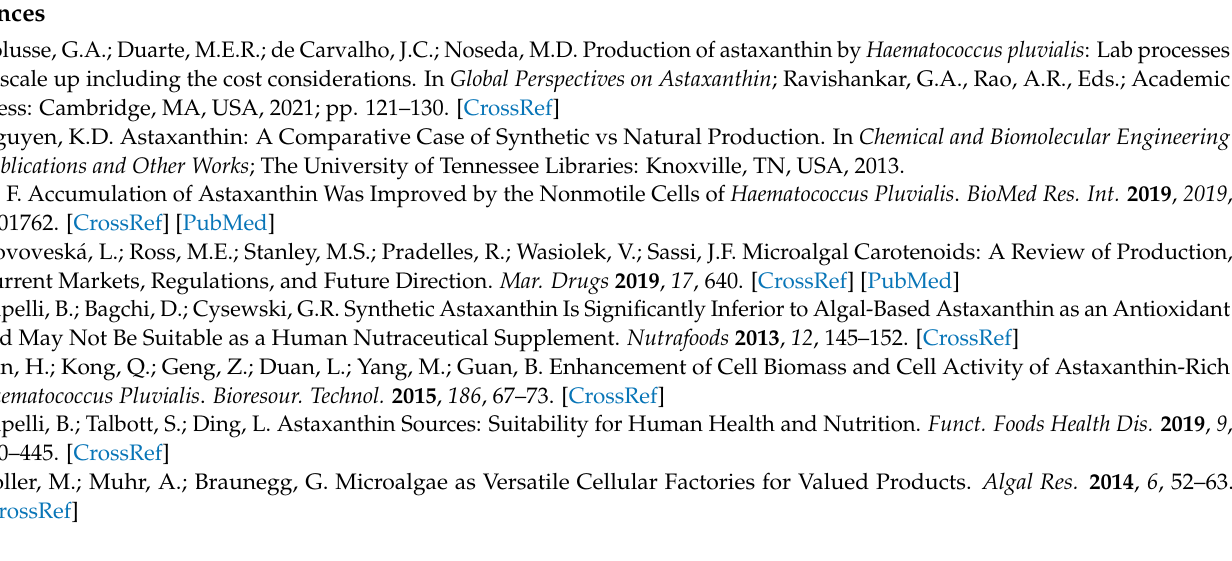
Figure S5: Representative HPLC chromatograms of H. pluvialis green (A) and red (B) phases of growth, when cultivated under FeNO 3 , NaNO 3 , NH 4 Cl, or Urea as the principal nitrogen source in Jaworski’s Media; Table S1: Biochemical table reporting the mean value (% DW) ± S.D. within samples ( n = 3); Table S2: Ordinary one-way ANOVA and Tukey’s multiple comparison test, with a single pooled variance were performed for H. pluvialis ; Table S3: The relative change of H. pluvialis CCAP 34/1D cell number based on the number of cells/mL at the beginning and end of the 7 day induction process; Table S4: Quantitative pigment composition (in mg/g DW), obtained by HPLC analysis, of H. pluvialis cells at the end of the green phase, in cultures previously supplied with equimolar concentrations of nitrogen from different sources; Table S5: For canthaxanthin, a t -test was used to determine if there is a significant difference between the means of two groups, NaNO 3 and FeNO 3 ; Table S6: Quantitative pigment composition (in mg/g DW), obtained by HPLC analysis, of H. pluvialis cells at the end of the red phases stationary phase, in cultures previously supplied with equimolar concentrations of nitrogen from different sources; Table S7: Pigments variation between the green and the red phase; Table S8: Ordinary two-way ANOVA and Sidak’s multiple comparison test, with individual variances computed for each comparison, were performed; Table S9: Carotenoids/Chlorophylls ratio analysis between the green and the red